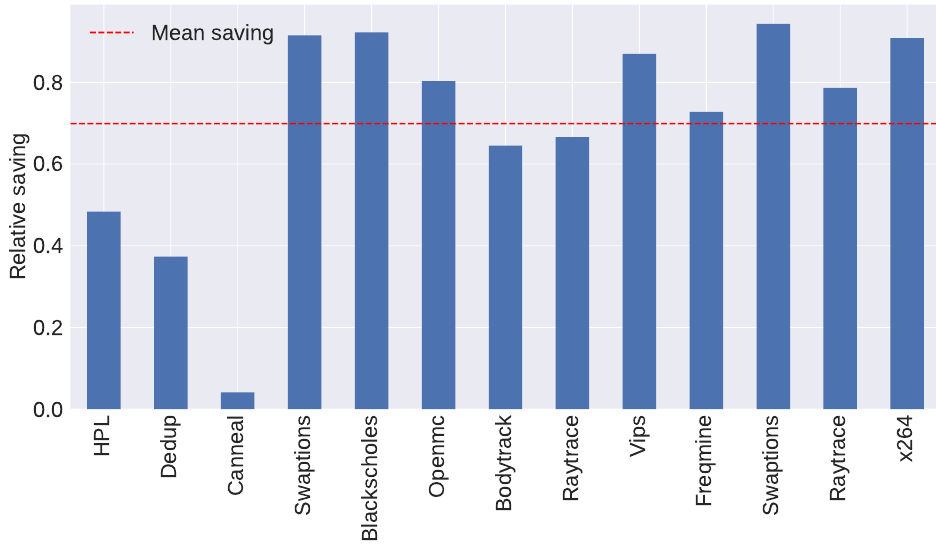
Figure 15. Energy savings comparisons between the proposed model and the Worst case.